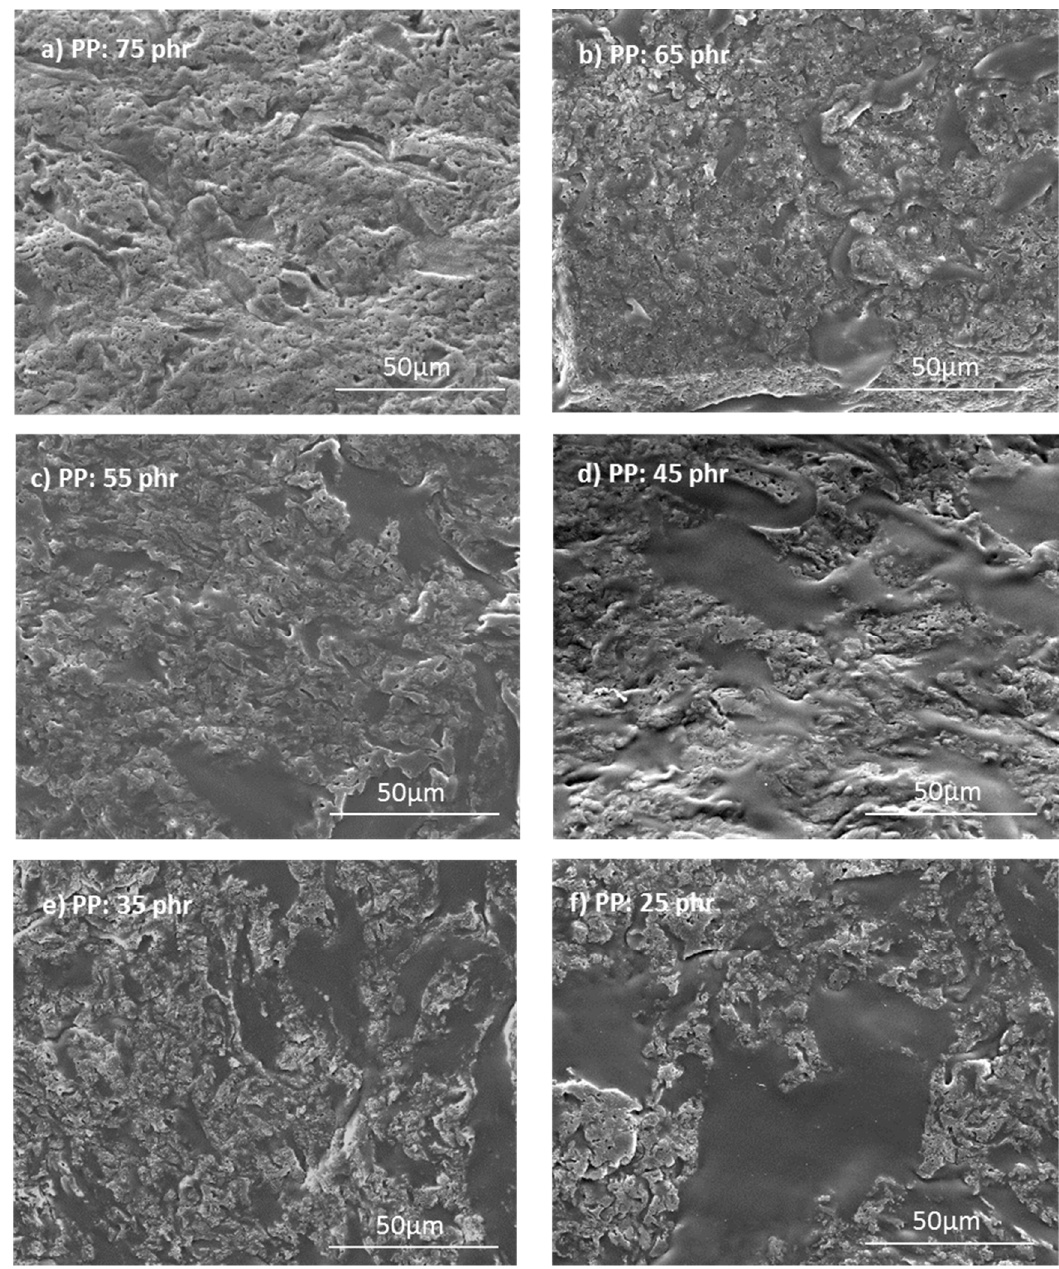
Figure 7. Evolution of the morphologies observed by SEM for TPV with di ff erent amounts of PP and crosslinked by DCP (4 phr).